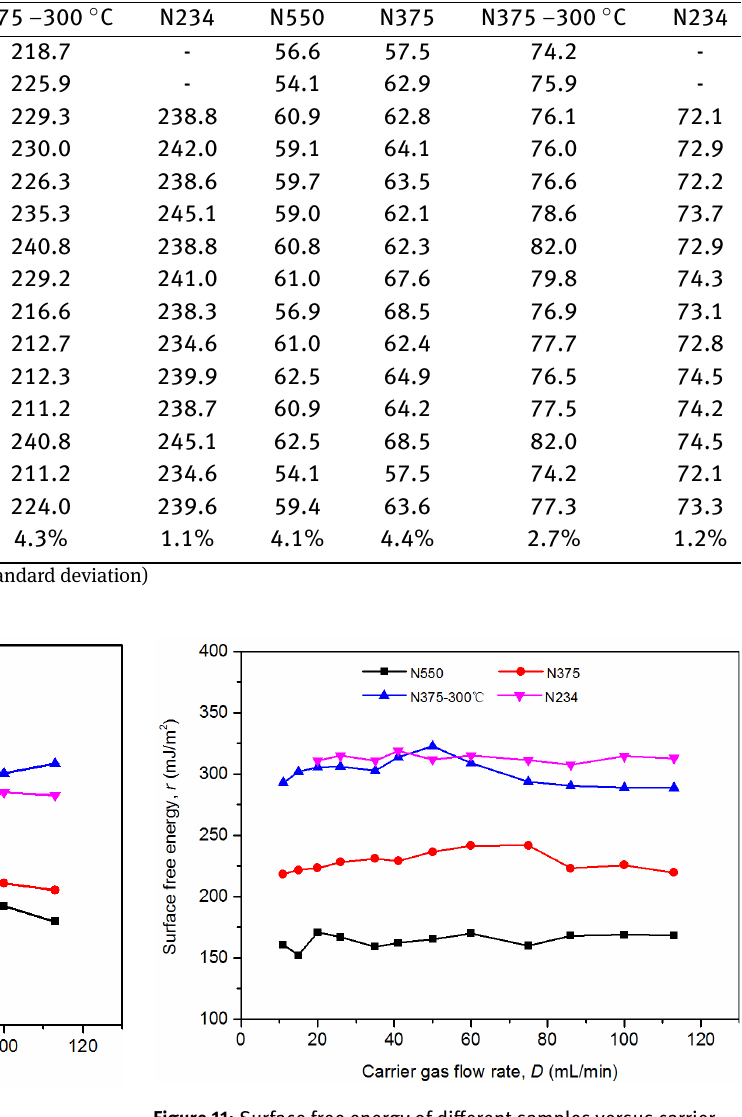
Figure 10: Polar parameter of different samples versus carrier gas flow rate ergy for different CB samples are consistent at different car- rier gas flow rates, demonstrating that the influence of car- rier gas flow rate on the dispersive free energy of different CB samples is the same. According to Figure 10, in case of the slow carrier gas flow rate, the vibration values of N550 and N375 are large. Consequently, small carrier gas flow rate should be avoided during experimental measure- ments. Under the condition of higher carrier gas flow rate, the fluctuation of the polar parameters is smaller, indicat- ing that the influence of the carrier gas flow rate on the po-